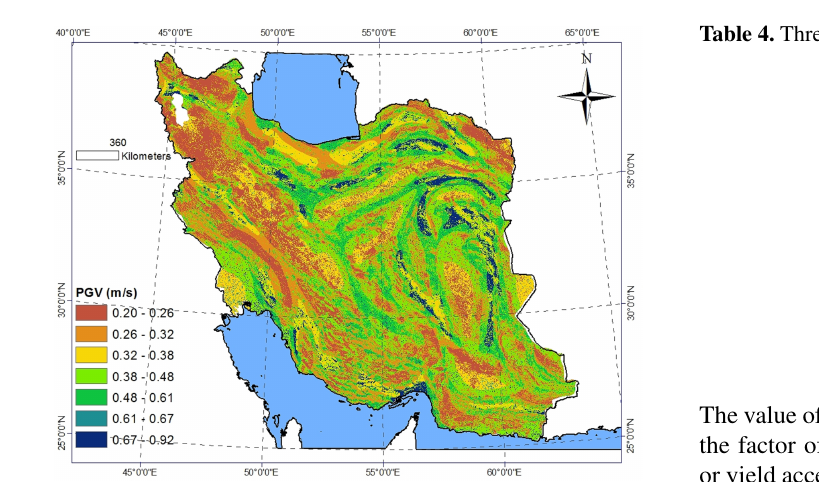
Figure 8. PGV map of the Iran by using Eq. (1) and GIS-based analyses. Table 3. Liquefaction susceptibility dependent parameters (FEMA, 2012).